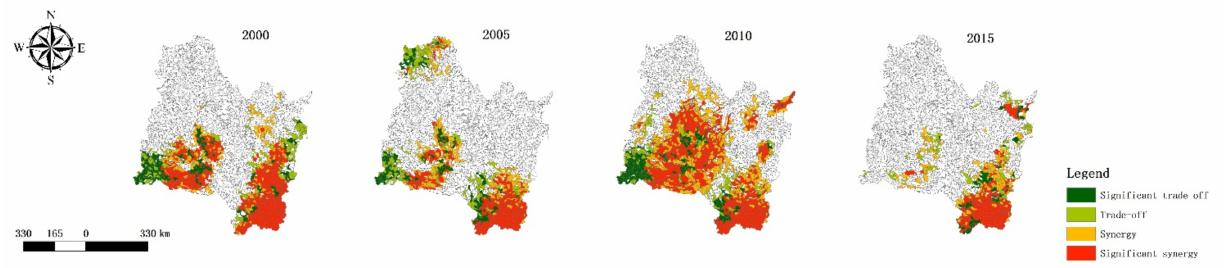
Figure 12. The synergy/trade-off relationship between water retention and carbon sequestration. The synergy/trade-off relationship between soil conservation and biodiversity in